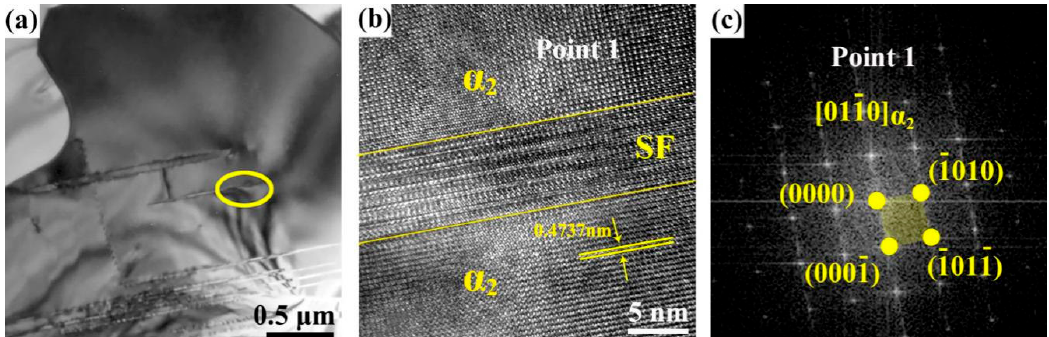
Figure 6. ( a ) Transmission electron microscopy (TEM) image of precipitated lamellae in the interior of α 2 grain, ( b ) high-resolution transmission electron microscopy (HRTEM) image of stacking faults, ( c ) Fast Fourier Transformation (FFT) pattern of point 1 in ( b